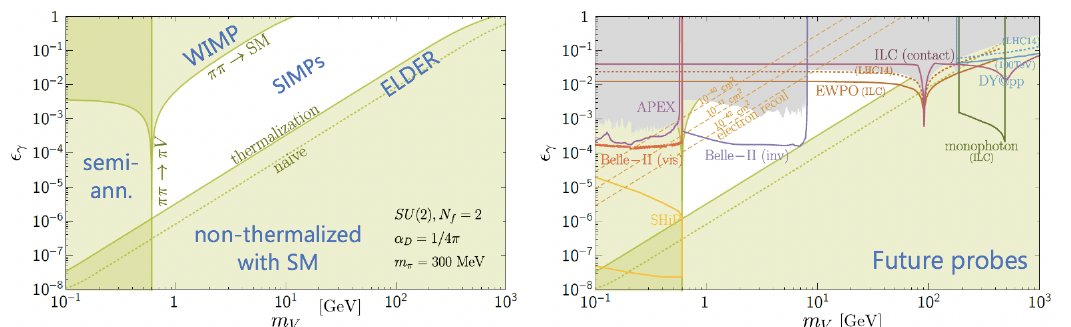
Figure 7: Reproduced from [ 16 ] . Left: Dark photon parameter space for fixed gauge group, dark coupling and dark pion mass, showing how different regions realize different DM mechanisms. Right: Constraints on the parameter space (shaded gray) and future probes (solid colored